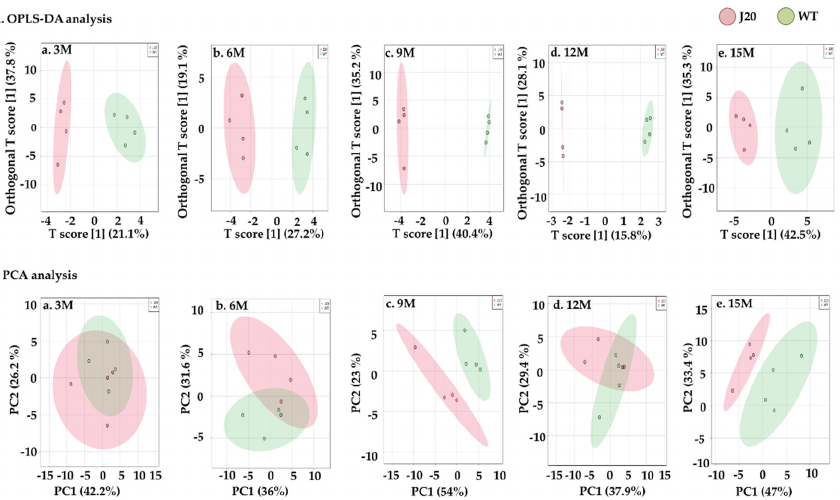
Figure 2. Orthogonal partial least square discriminant analysis (OPLS-DA) and principal component analysis (PCA) of Pls-PE in the J20 and WT mice. Four mice were used in each group for J20 and WT mice at each time point. OPLS-DA analysis ( A ) at 3 M ( A . a ), 6 M ( A . b ), 9 M ( A . c ), 12 M ( A . d ), and 15 M ( A . e ), and PCA analysis ( B ) at 3 M ( B . a ), 6 M ( B . b ), 9 M ( B . c ), 12 M ( B . d ), and 15 M ( B . e ) were conducted with the measured Pls-PE by using MetaboAnalyst 5.0 software. Pink-colored circles indicate Pls-PE distribution in J20 mice, and green-colored circles indicate Pls-PE distribution in WT mice. M indicates months.